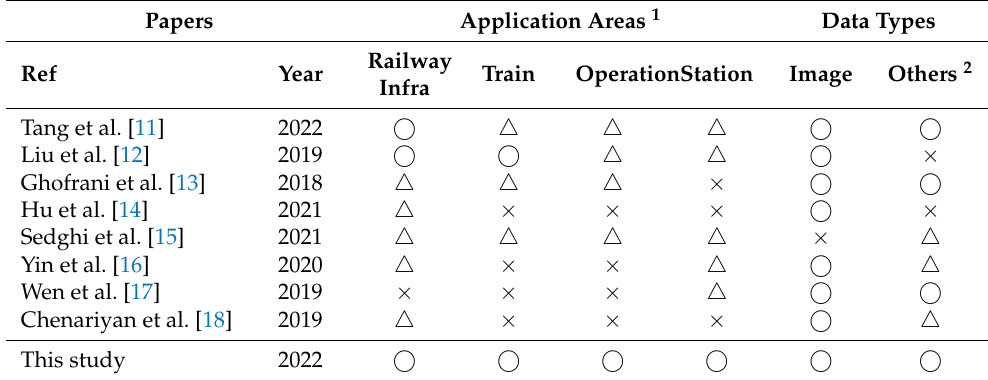
Table 1. Coverage of Existing Reviews about the Railway Safety.